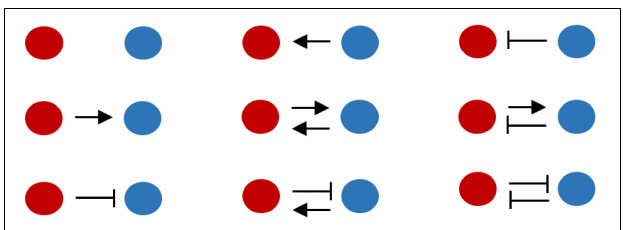
FIGURE 1 | Nature and magnitude of interactions between species dictates criteria for stable coexistence. Two species A (red) and B (blue) in an environment can exhibit nine topologies depending on how presence of one impacts growth of the other. In this cartoon, we assume that species A (red) grows slower than B (blue), when growing in absence of any other species. Arrow represents synergistic interaction while a blunt end represents an antagonistic